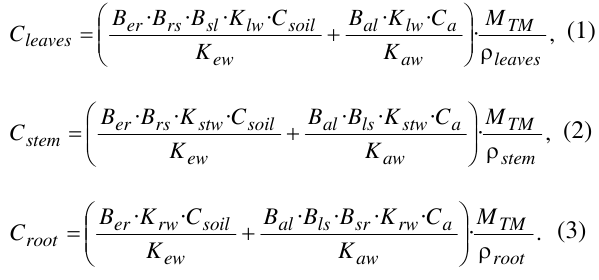
Fig 1. Experimental site for industrial sewage sludge uti- lization in Git ė nai forest of Taruškos forestry located in Panev ė žys region (Lithuania) Equations involved in the model for computing con- centrations in roots ( C ), the stem ( C ) and leaves root stem ( C ) are given below. The description and the units of leaves variables are given in Table